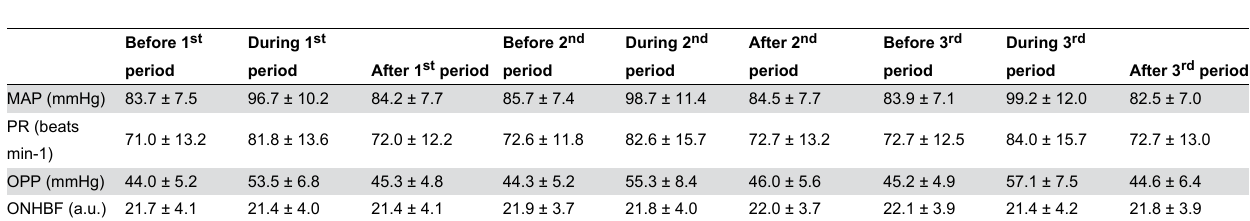
Table 3. Effects of isometric exercise (handgripping, 3 periods) on mean arterial pressure, pulse rate, ocular perfusion pressure, and optic nerve head blood flow in all patients (n=39, means ±